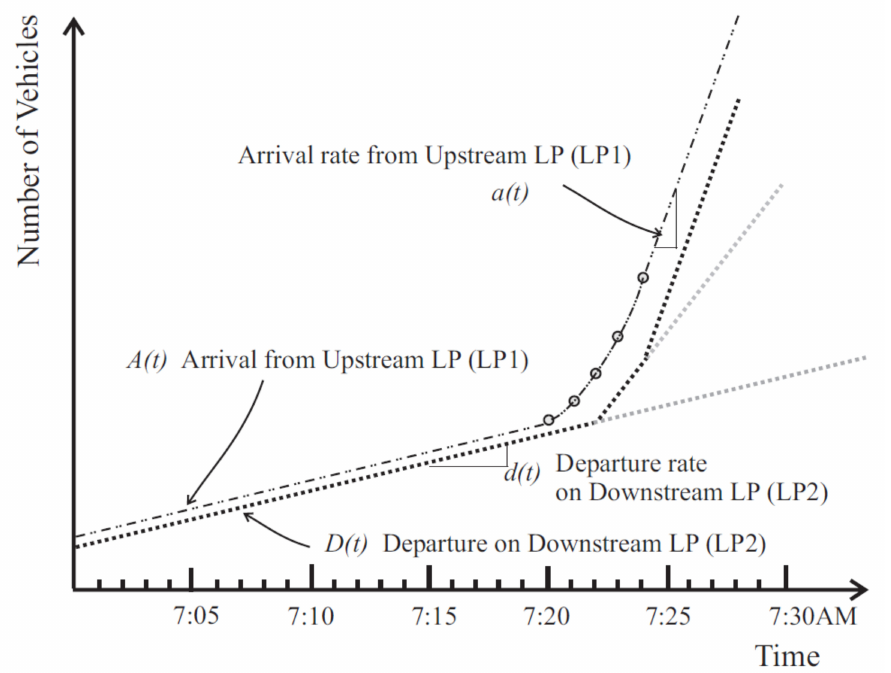
Figure 4. Cumulative number of vehicle diagram for ad hoc distributed